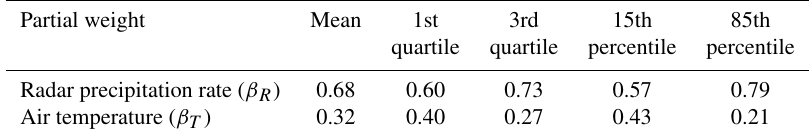
Table 2. Summary statistics of computed partial weights for radar precipitation rate and air temperature in the study area. Partial